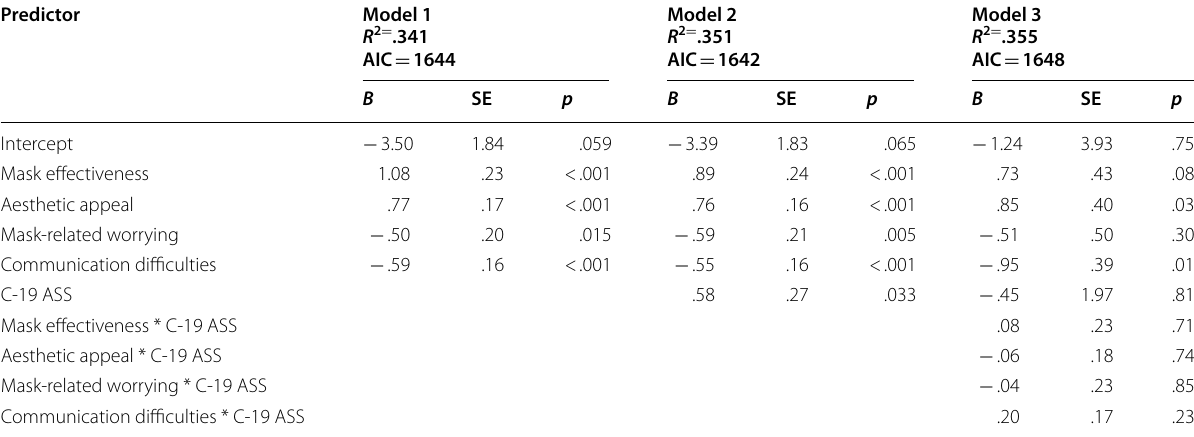
Explicit mask preference scores ranged from 6 to 6. Covid 19 Anxiety Syndrome Scale scores ranged from 0 to 4. Mask effectiveness, aesthetic appeal, mask-related − worrying, and communication difficulties scores ranged from 1 to7